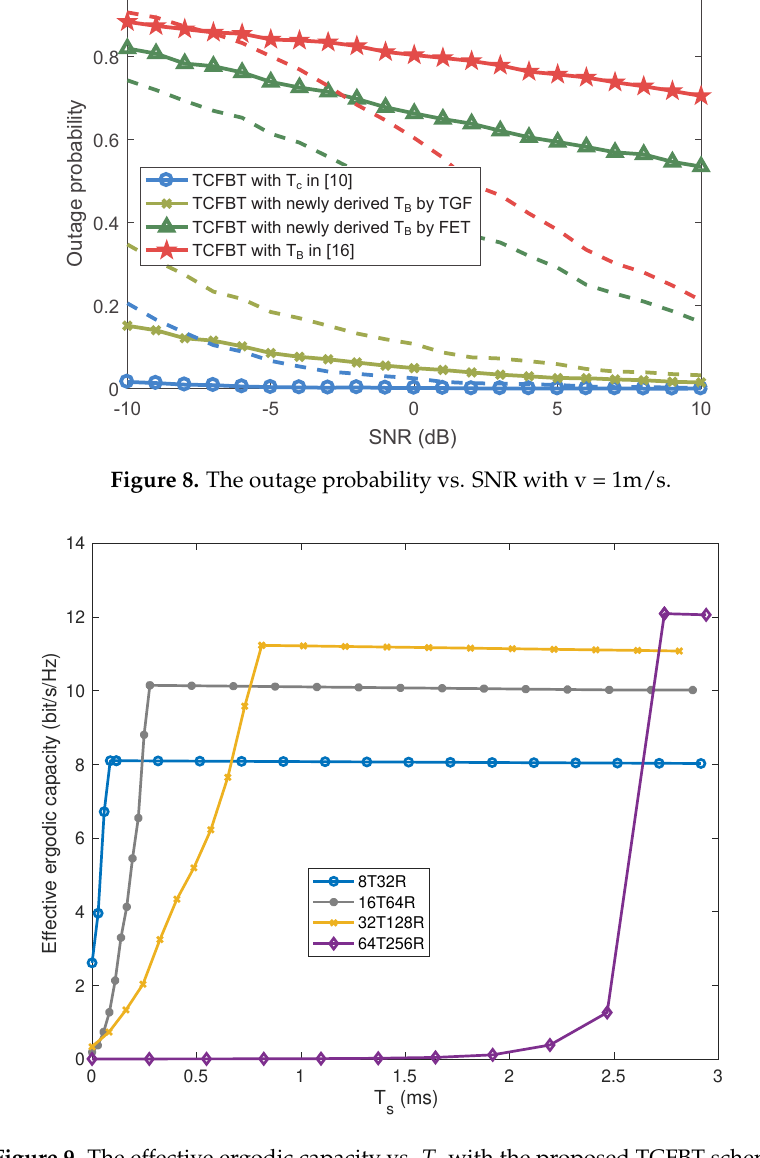
Figure 9. The effective ergodic capacity vs. T s with the proposed TCFBT